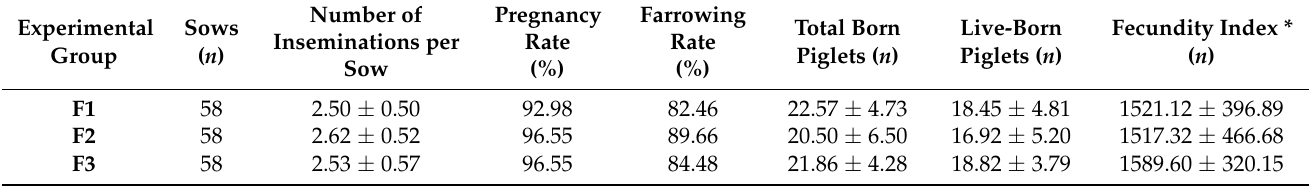
Table 4. Pregnancy rate (%), farrowing rate (%), total litter size, live-born piglets, and fecundity index (mean ± standard deviation) in inseminated sows from three experimental groups (F1, F2, F3).